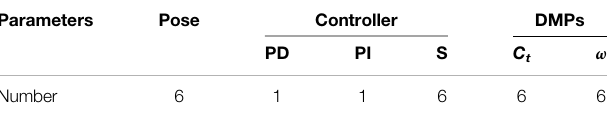
TABLE 2 | Action space of the learning